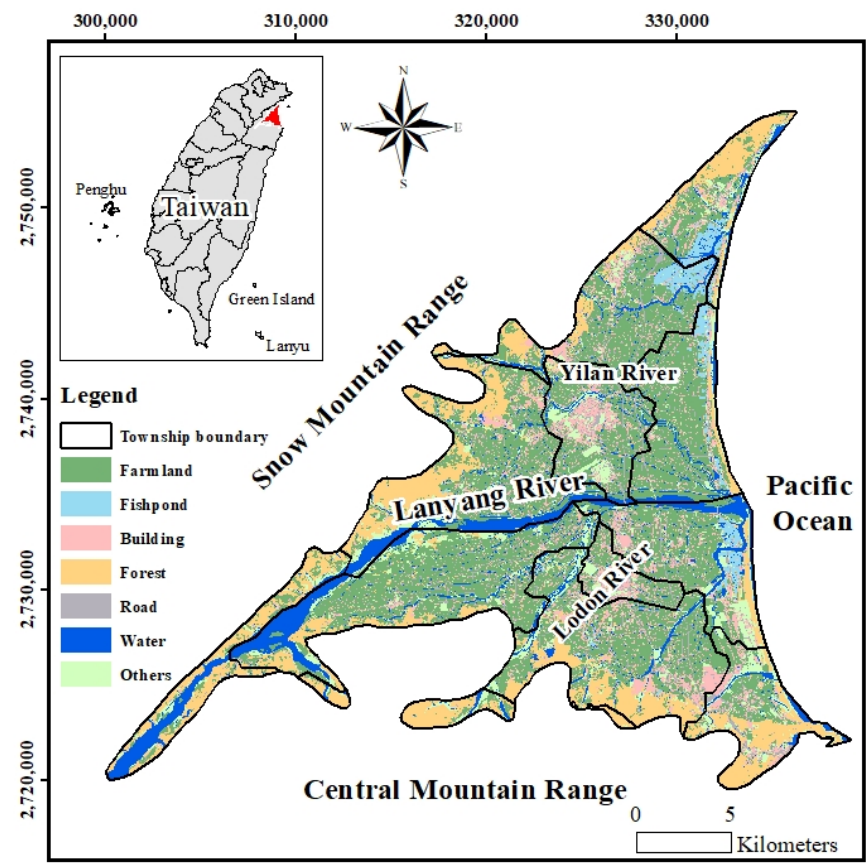
Figure 1. Land use in the Lanyang Plain.